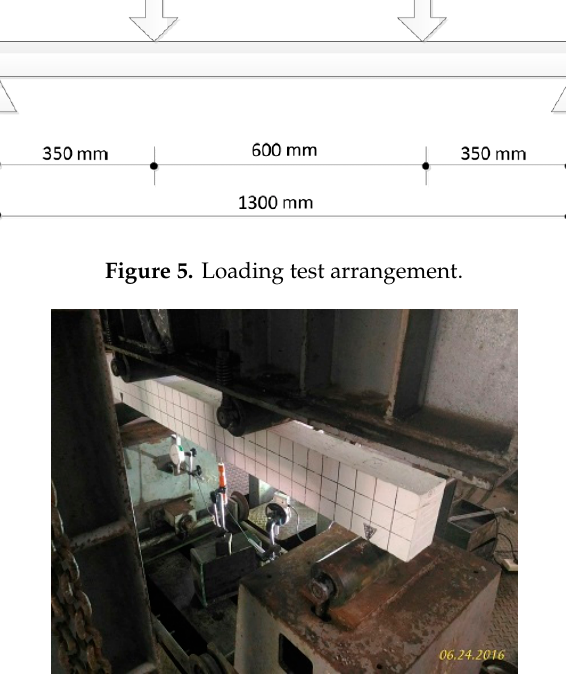
Figure 6. Loading test of geopolymer concrete beam (GCB).